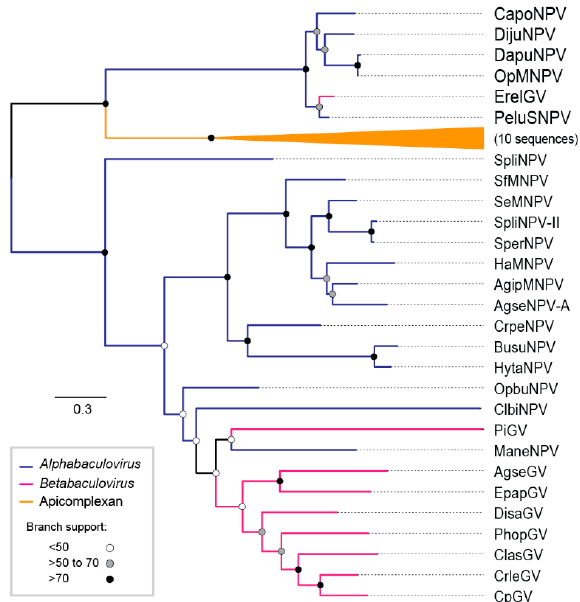
Figure 6. Phylogeny of a putative thymidylate kinase homolog found in the DijuNPV genome. Phylogeny of DijuNPV-ORF-126, a homolog of cp016-like. Erinnyis ello granulovirus (ErelGV), OpMNPV, Dasychira pudibunda nucleopolyhedrovirus (DapuNPV), Perigonia lusca single nucleopolyhedrovirus (PeluSNPV), Catopsilia pomona nucleopolyhedrovirus (CapoNPV), and DijuNPV-derived proteins clustered together, indicating common ancestry. The tree was rooted at the midpoint for clarity.